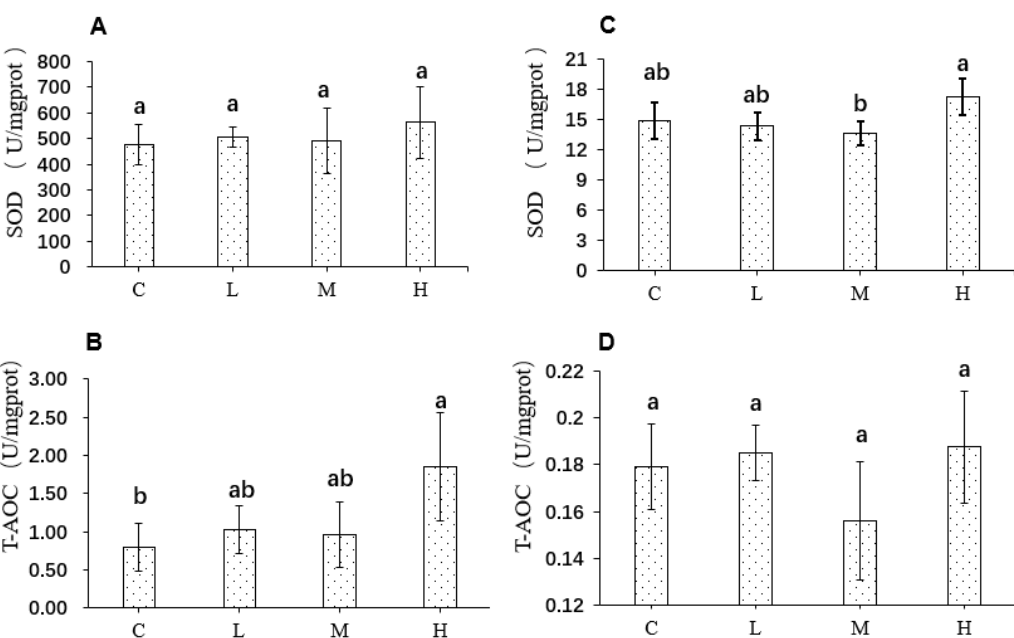
Figure 3. Redox status in the liver ( A , B ) and colon ( C , D ) of mice after treatments of FRJ. C: mice fed with standard diet; L: mice fed with 3% (wt:wt) FRJ supplementation; M: mice fed with 6% (wt:wt) FRJ supplementation; H: mice fed with 9% (wt:wt) FRJ supplementation. Different letters indicated significantly different at p < 0.05. SOD:Superoxide dismutase; T-AOC:Total antioxidant capacity.